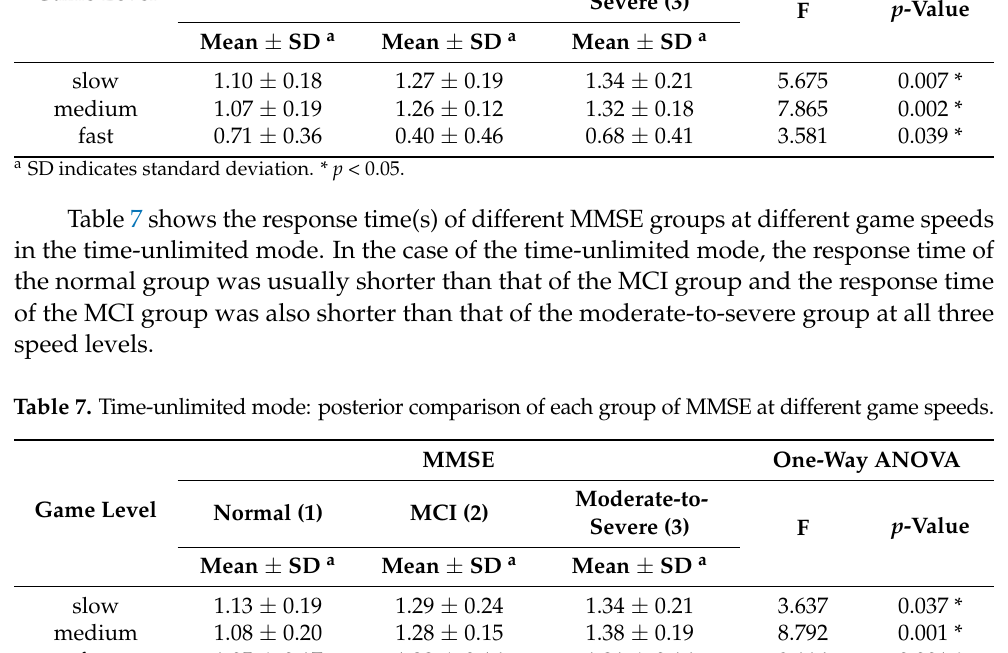
Table 6. Time-limited mode: the response time(s) of each group of MMSE at different game speeds. MMSE One-Way ANOVA Normal (1) MCI (2) Game Level